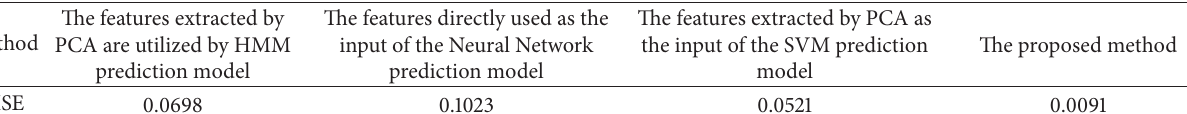
Table 5: The RMSE results of different prediction methods.